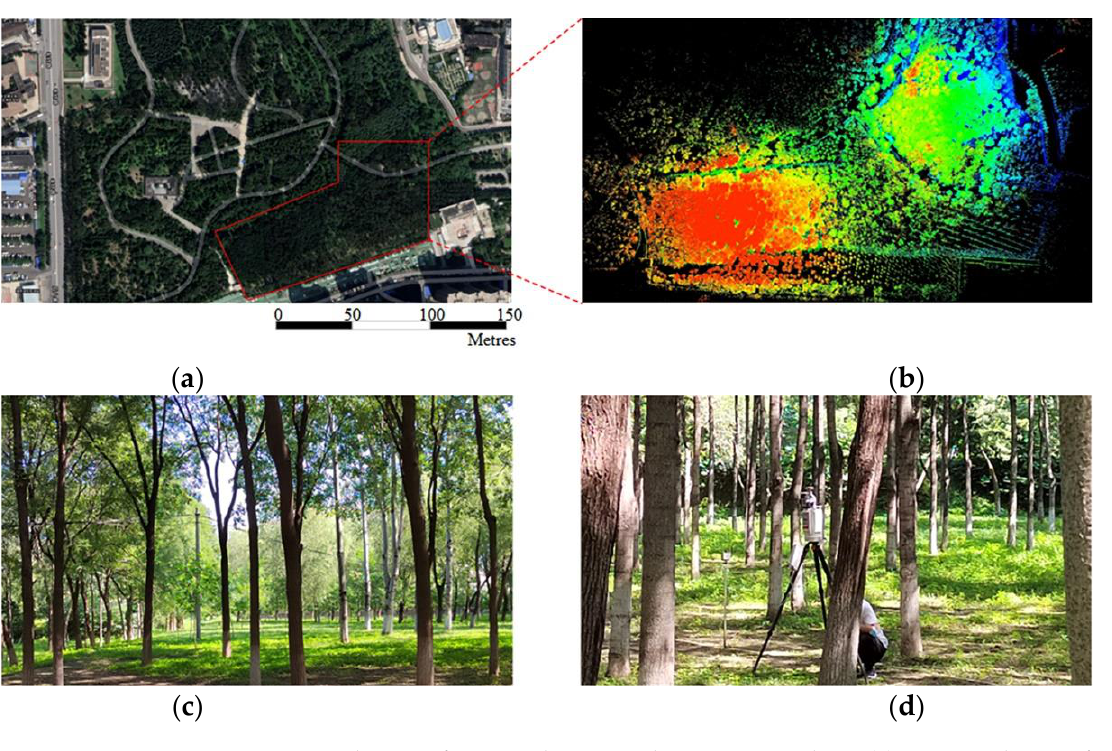
Figure 2. Study area of Bajia Park in Dongsheng, Beijing, China: ( a ) RGB aerial view of Bajia Park; ( b ) Aerial view of the point cloud map of the sample site; ( c ) RGB image of the white sample site shown in the figure, which clearly shows the relationship between tree plant distribution; ( d ) Our use of TLS to collect data.